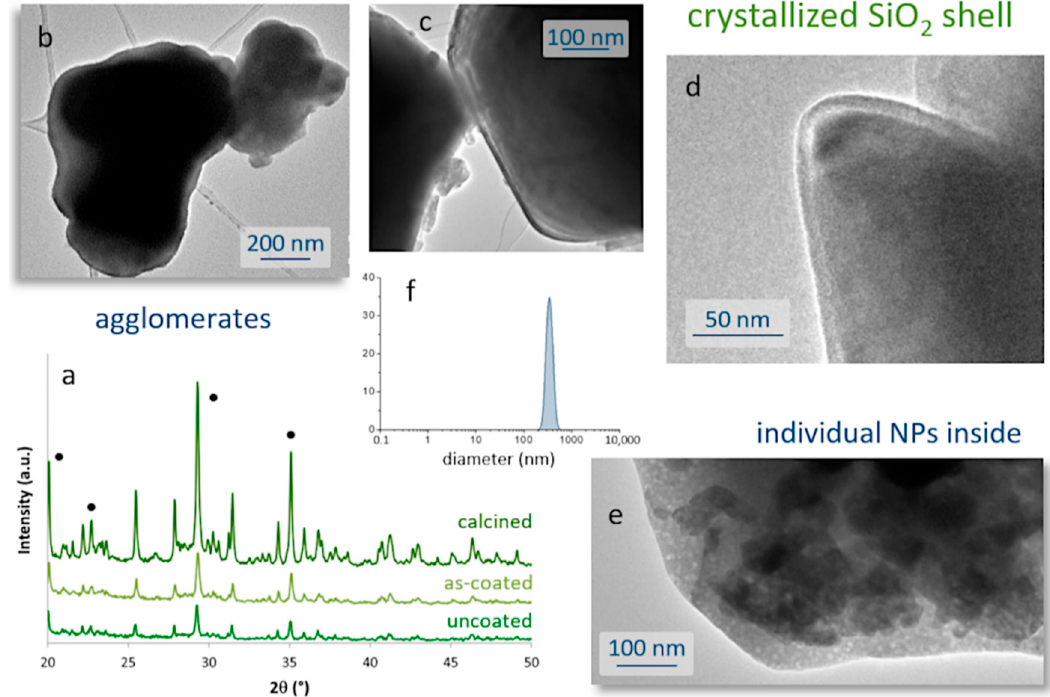
Figure 6. Crystallization of the silica shell to consolidate the SrAlO:Eu,Dy@SiO 2 composites. ( a ) Evo- lution of the crystalline phases after coating and subsequent calcination at 400 °C, as followed by XRD. Black circles indicate the maxima of the SrAl 2 O 4 phase, all other peaks correspond to the Sr 4 Al 14 O 25 phase. ( b – e ) TEM images of the calcined core-shell composites. ( f ) Particle size distribution after crystallization.